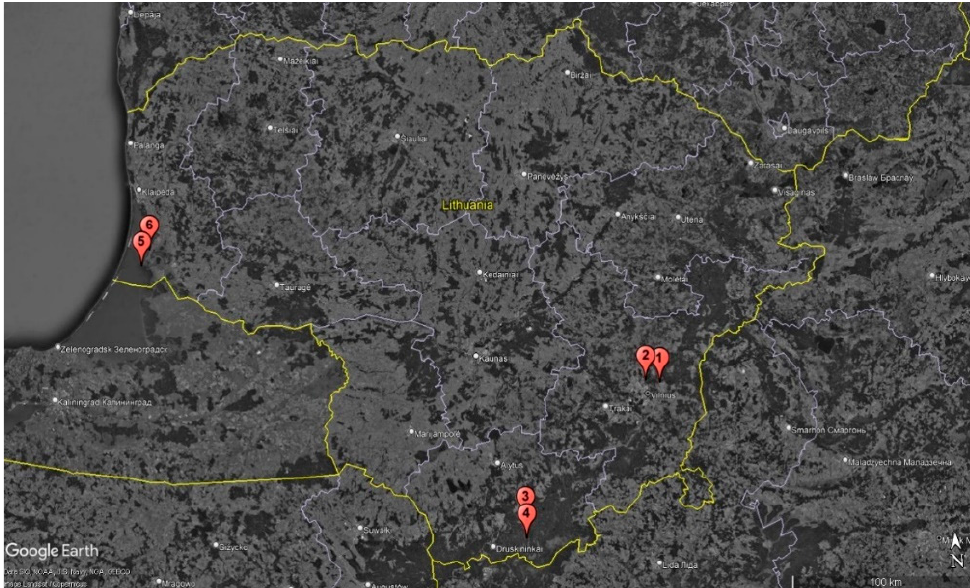
Figure 1. Collection sites in Lithuania: Verkiai Regional Park (1), Vilnius University Botanical Garden (2), Puvo č iai (3 and 4), Vent ė s Ragas (5), and its surroundings (6). Produced with Google Earth Pro v. 7.3.6.9277.